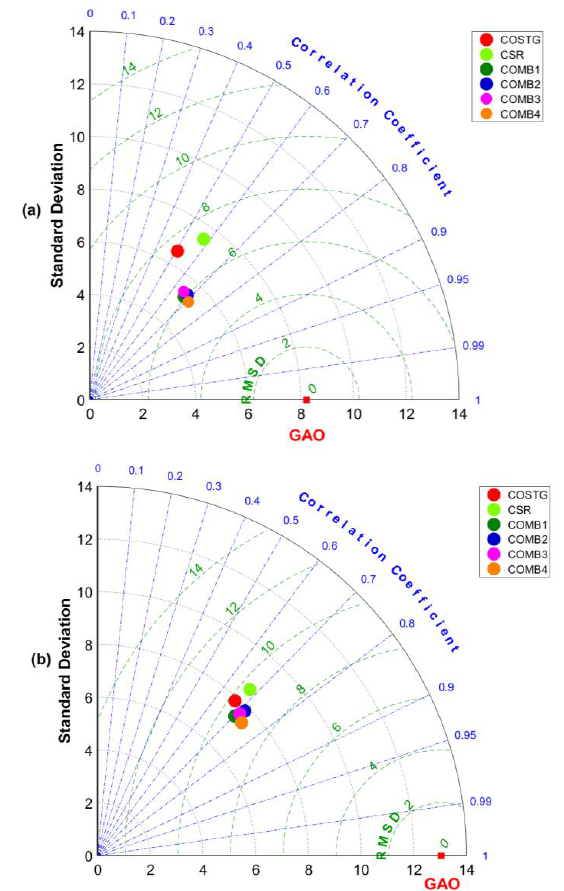
Figure 5. Taylor diagrams showing a comparison of χ 1 ( a ) and χ 2 ( b ) components of GAO (treated as a reference value), with gravimetric excitation determined from a single GRACE/GRACE-FO so-